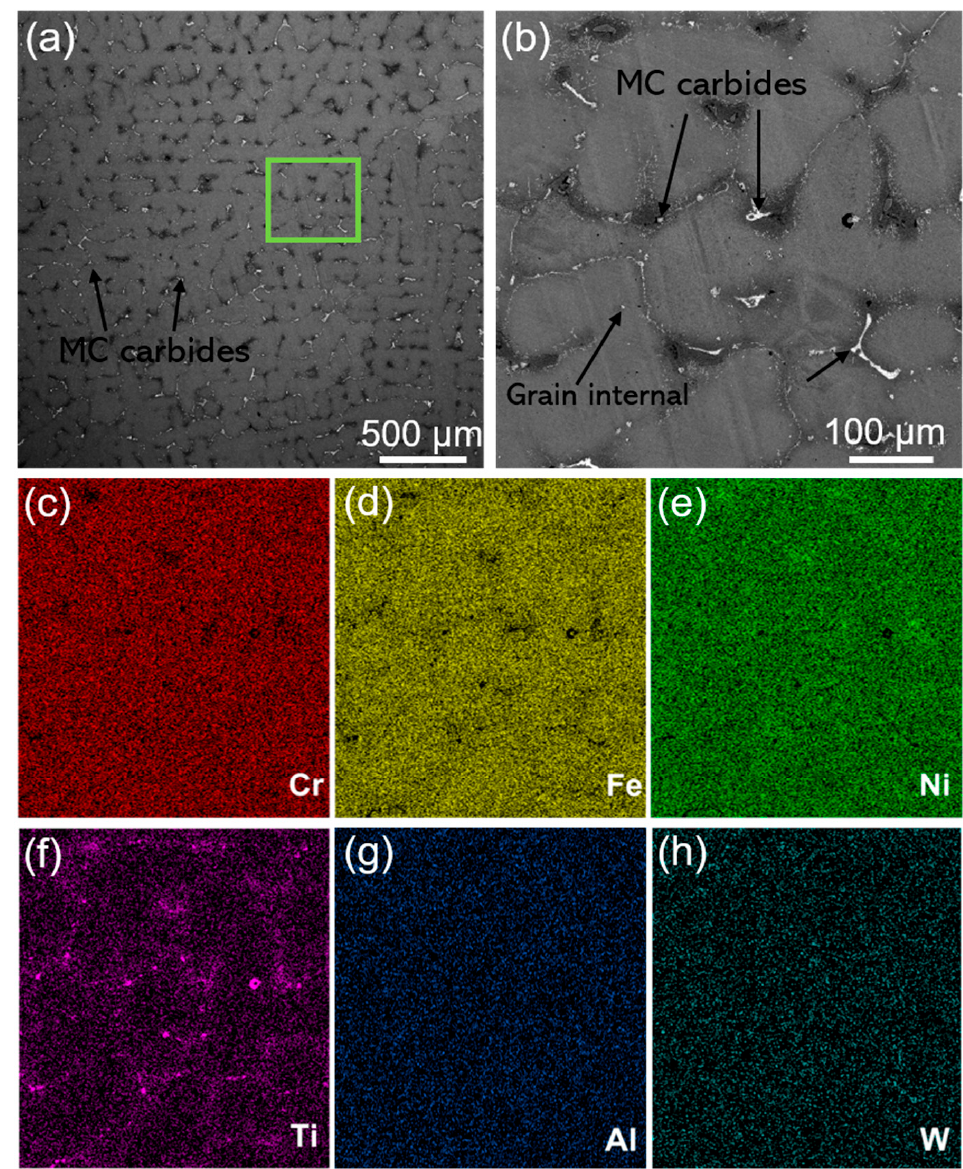
Figure 3. ( a ) Microstructure of as-cast K213 alloy. ( b ) Local magnified area of the green box in ( a ). ( c – h ) Distribution maps of corresponding main components.